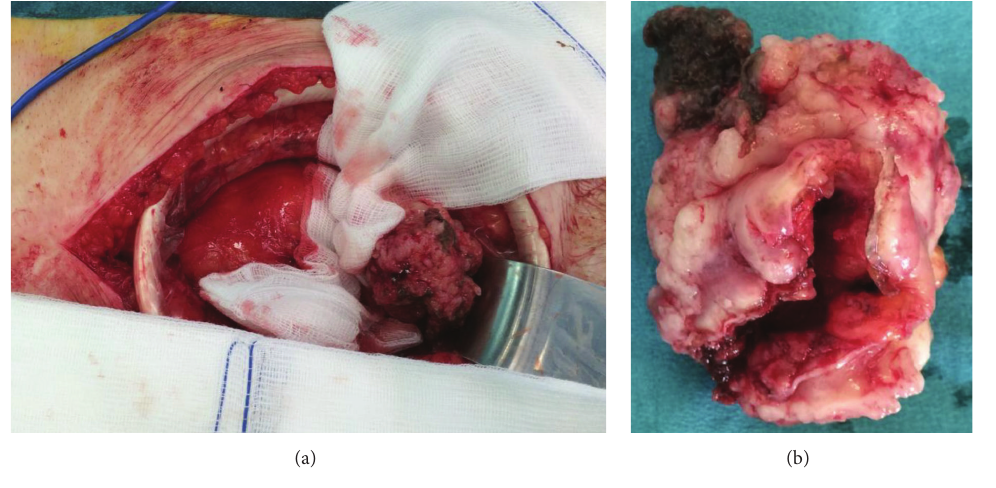
Figure 6: Intraoperative view (a) and resection specimen (b).